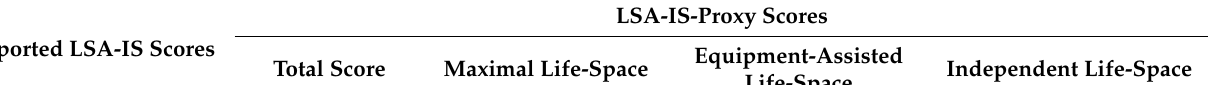
Self-Reported LSA-IS Scores